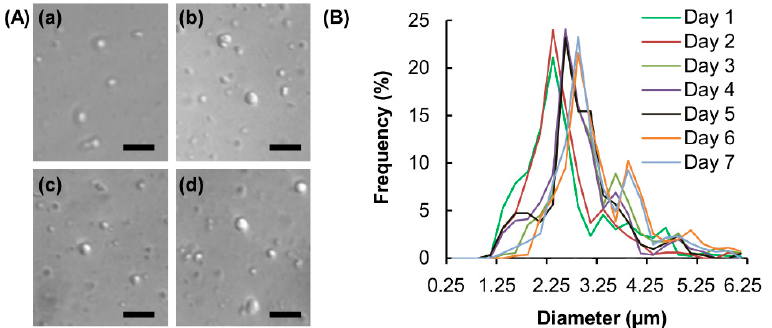
Figure 1. ( A ) Microscopic images of blank vesicles taken ( a ) 1, ( b ) 3, ( c ) 5 and ( d ) 7 days after the preparation process. Scale bar = 10 µm. ( B ) The size distribution profiles of blank vesicles sampled at different time intervals after vesicle fabrication.